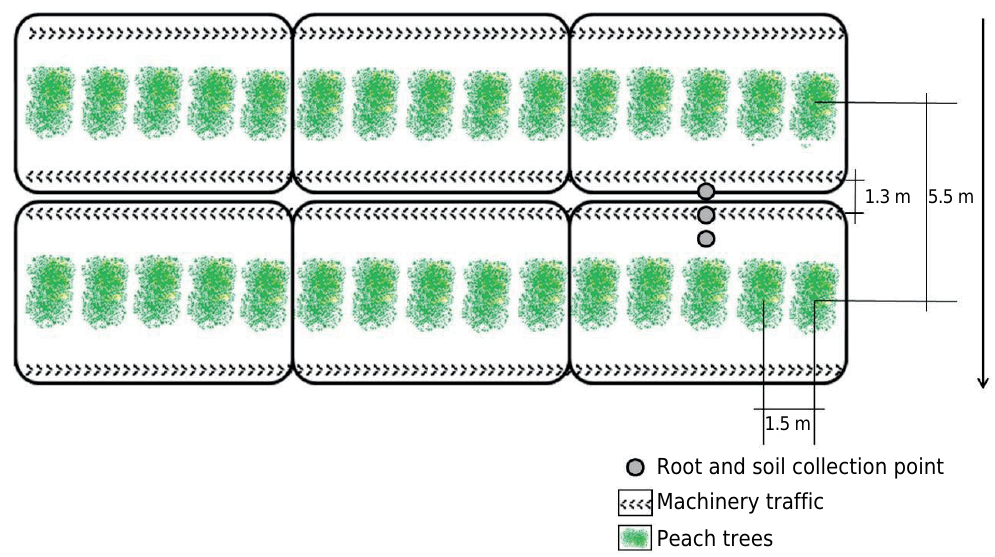
Figure 1. Schematic representation of collection points in the inter-row of the experimental plot in the orchard of ‘Maciel’ peach grafted onto ‘Okinawa’ and ‘Nemaguard’. EEA-UFRGS, Eldorado do Sul, Brazil, 2013. The arrow represents slope